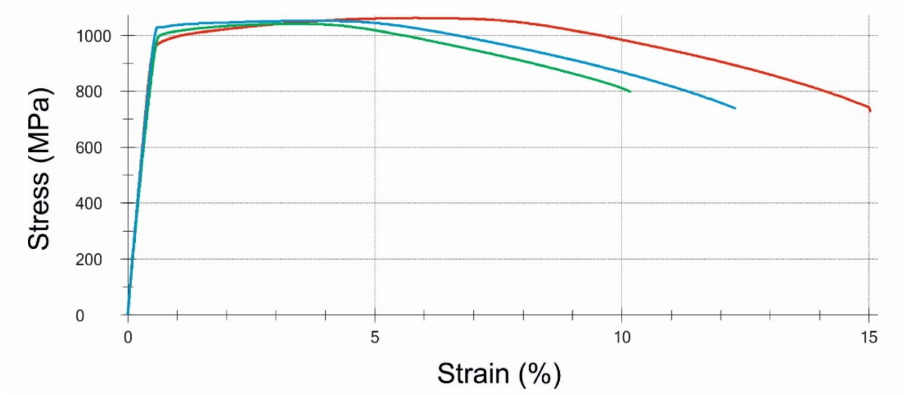
Figure 14. Stress-strain curves obtained for three specimens taken from the S1 bolt.